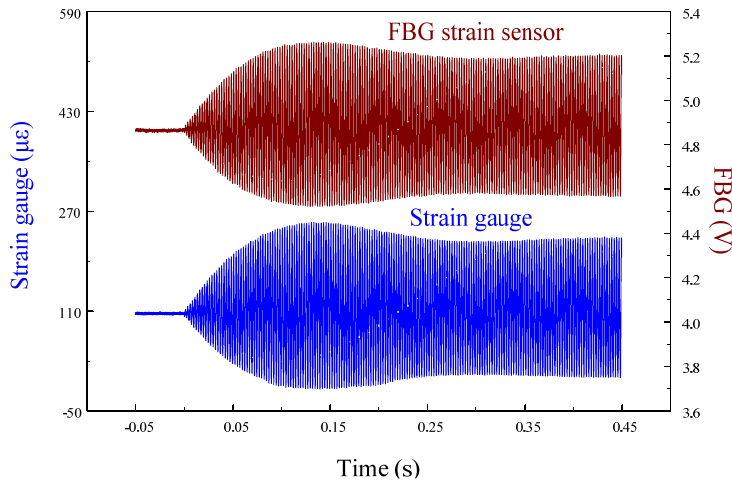
Figure 13. Transient strain responses of the smart cantilever beam excited by the piezoelectric actuator at 400 Hz.